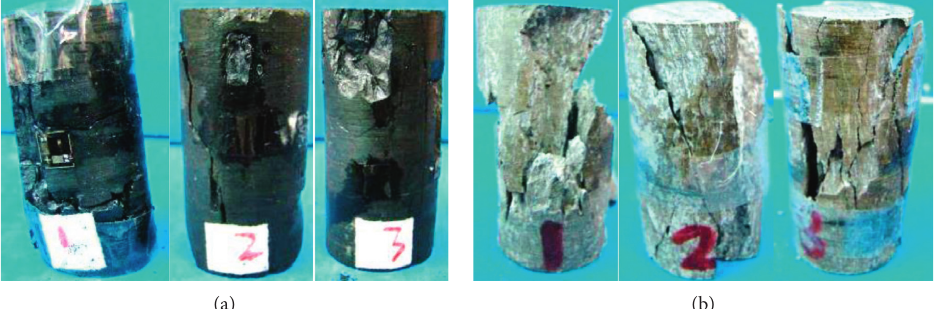
Figure 3: Fracture patterns of coal and rock samples under uniaxial compression. (a) Coal samples. (b) Sandstone samples.